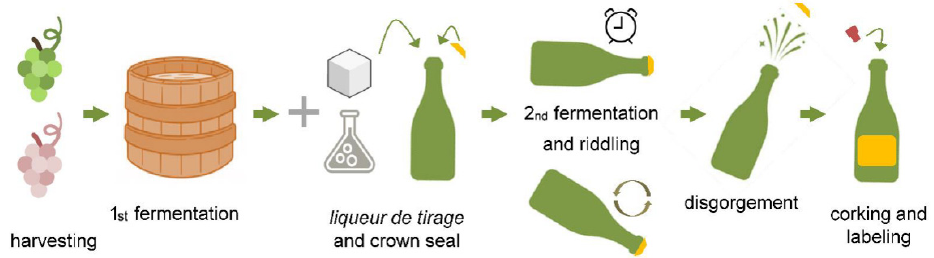
Figure 1. An i llustrative description of Champenoise sparkling wine production. Image reproduced from [13]. duced from